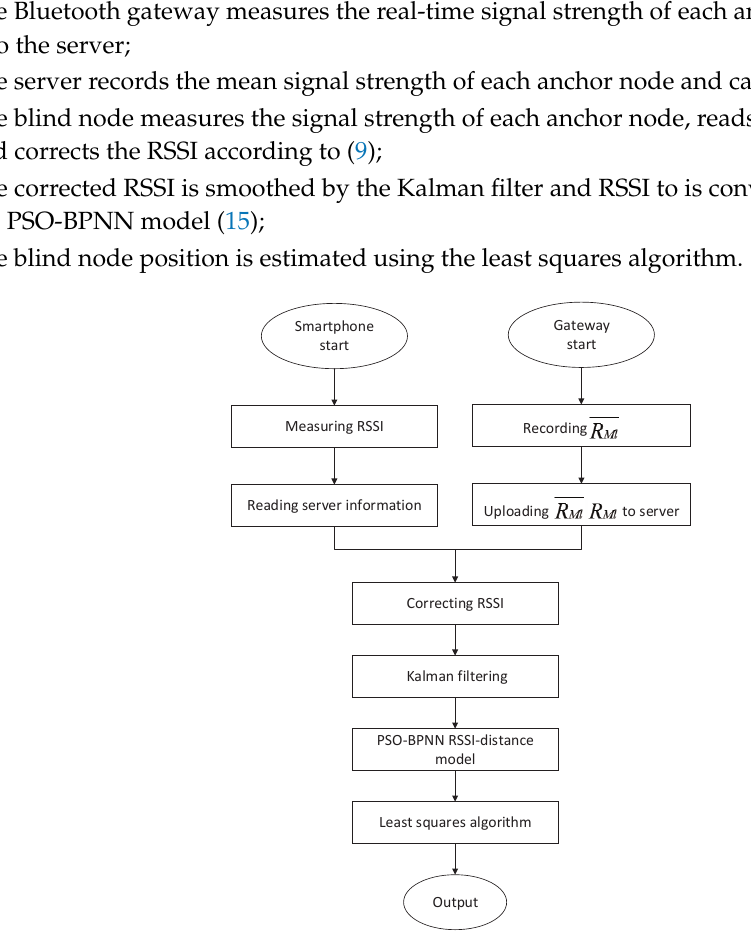
Figure 4. The positioning schematic